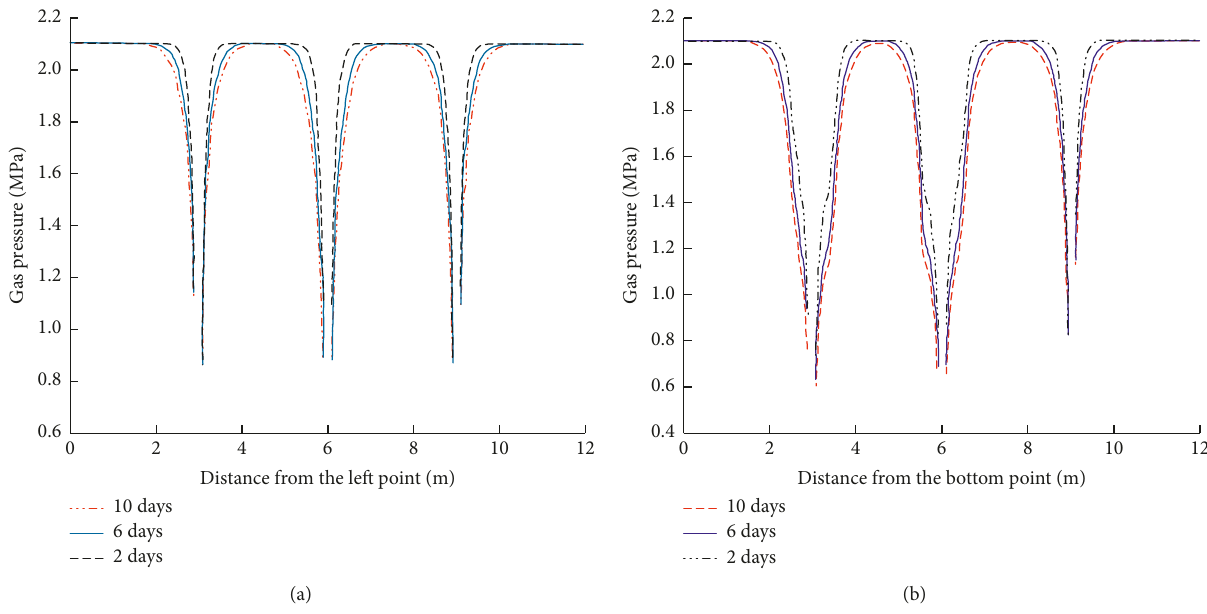
Figure 14: Curves for gas pressure under varying gas drainage times on survey lines. (a) Horizontal survey line. (b) Vertical survey